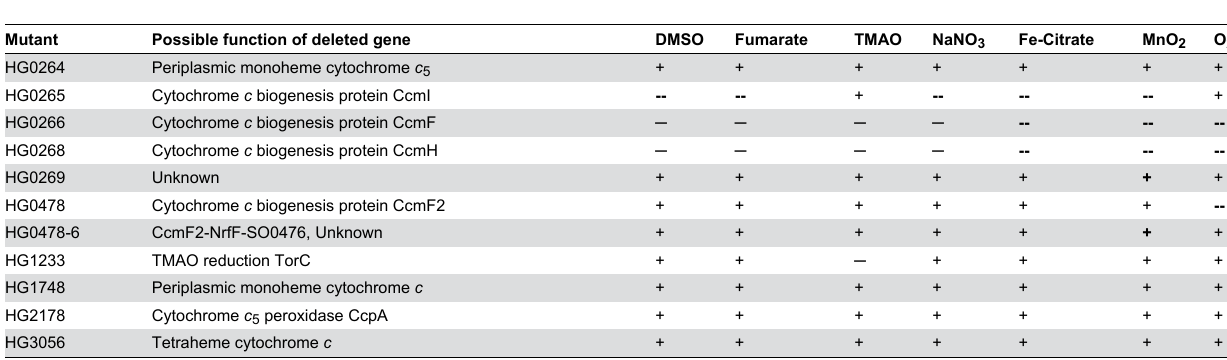
Table 1. Physiological characterization of mutants constructed in this study a .